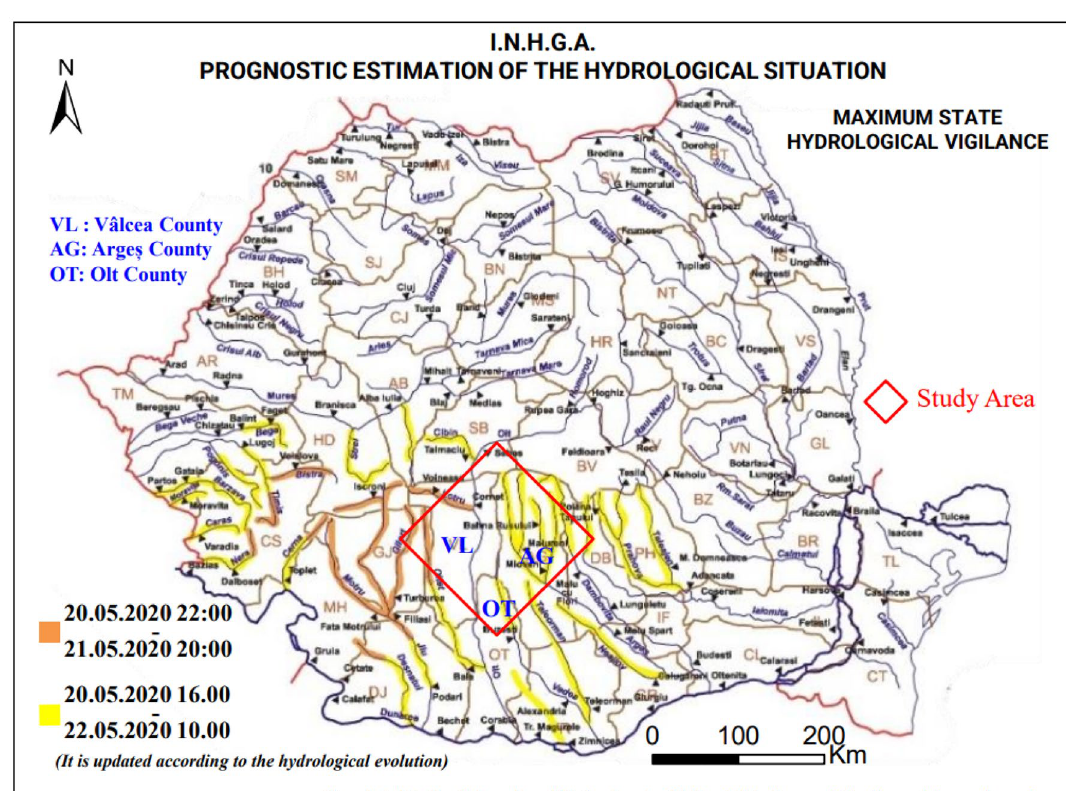
Figure 13. Hydrological warning map, translated to English and modified using ArcGisPro 2.8.1, showing rivers in flood on May 20, 2020: yellow—first warning level and orange—second warning level (out of three). Source: http:// www. inhga. ro/ warni